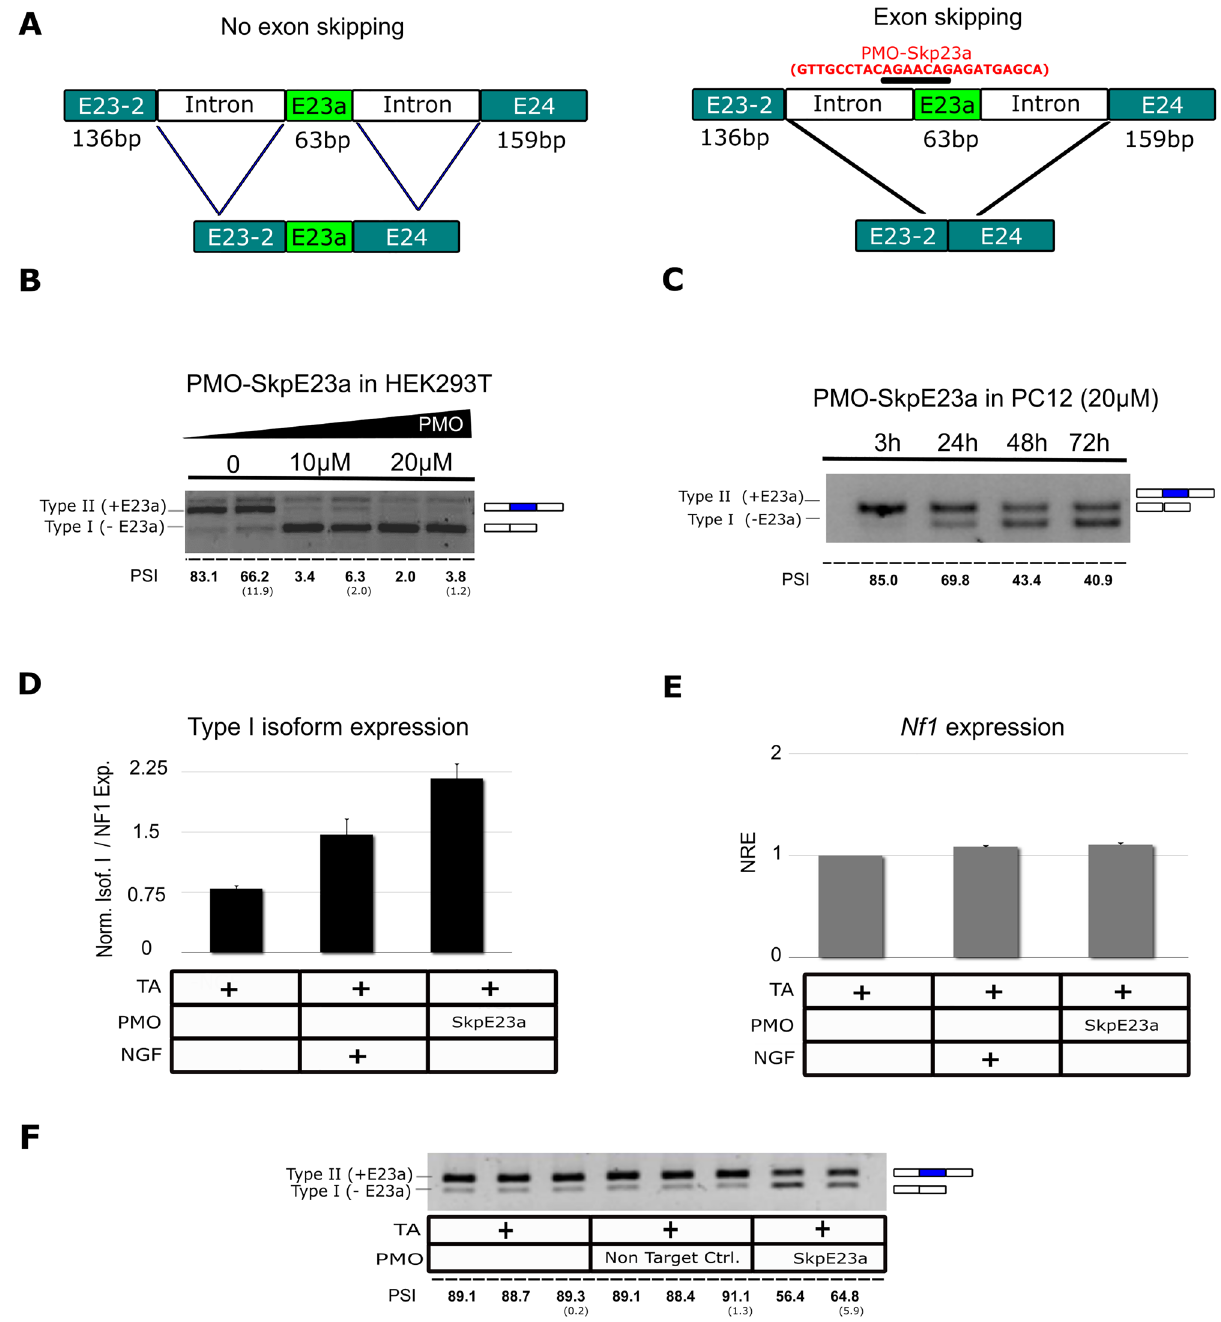
Figure 2. Design of a PMO to force the skipping of E23a and experimental conditions set up. ( A ) Schematic diagram of E23a skipping strategy using PMO-SkpE23a (in red) targeting its acceptor splice site. ( B ) Dose– response analysis at different PMO-SkpE23a concentrations in HEK293T cells measured by RT-PCR. ( C ) Time course experiment using PMO-SkpE23a in PC12 cells measured by RT-PCR. ( D ) Relative mRNA isoform type I (-E23a) expression normalized by the total Nf1 expression at 72 h, measured by RT-qPCR. ( E ) Total Nf1 expression levels at 72 h after PMO addition, measured by RT-qPCR. ( F ) Expression of Type II/I isoforms in PC12 cells treated with transfection agent (TA), a non-targeting control PMO and PMO-SkpE23a, 72 h after PMO addition and measured by RT-PCR. For all plots, bars indicate Mean ± SEM. NRE: Normalized Relative Expression. All supporting uncropped gels can be found in Supplementary Fig. S2. E23a splicing was quantified as the percent spliced-in (PSI) (standard deviation in